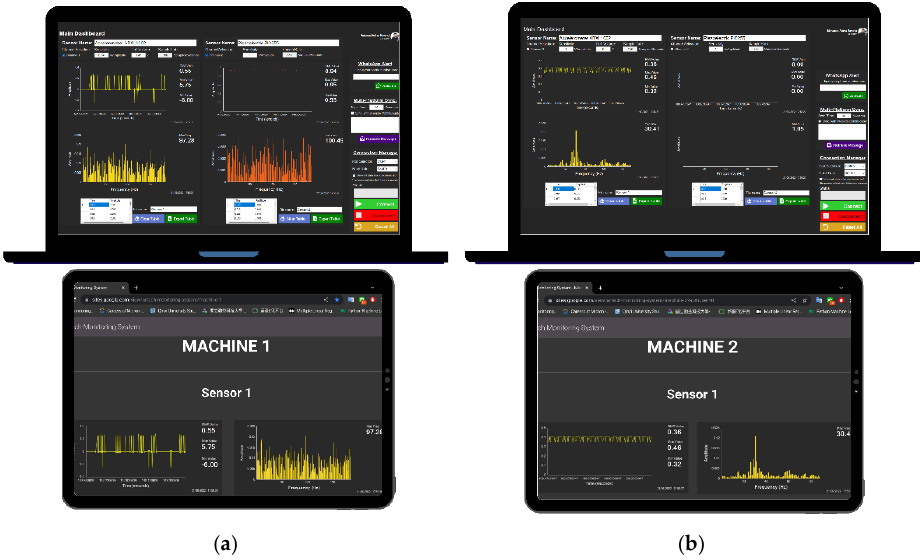
Figure 16. CPMA applicated to two different machines: ( a ) first machine and ( b ) second machine. A MEMS accelerometer and a piezoelectric sensor were used in the first machine. Only a piezoelectric sensor was installed on the second machine. Although the system